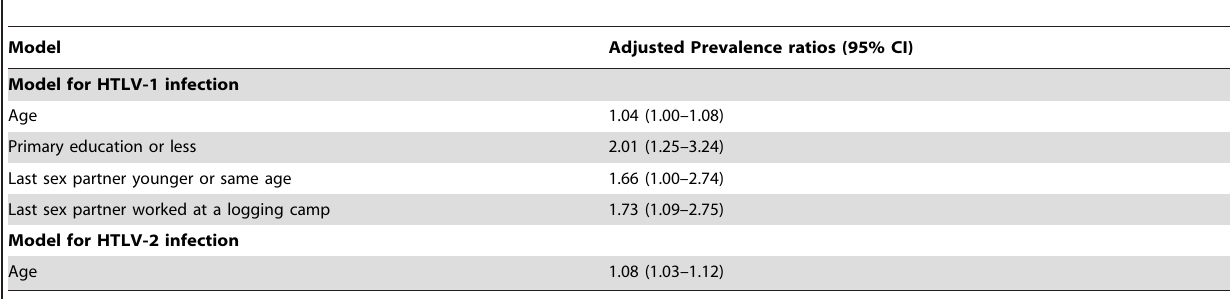
Table 2. Multivariate analysis of factors associated with human T cell lymphotropic virus type 1 (HTLV-1) and HTLV-2 infections in women from the Shipibo-Konibo ethnic